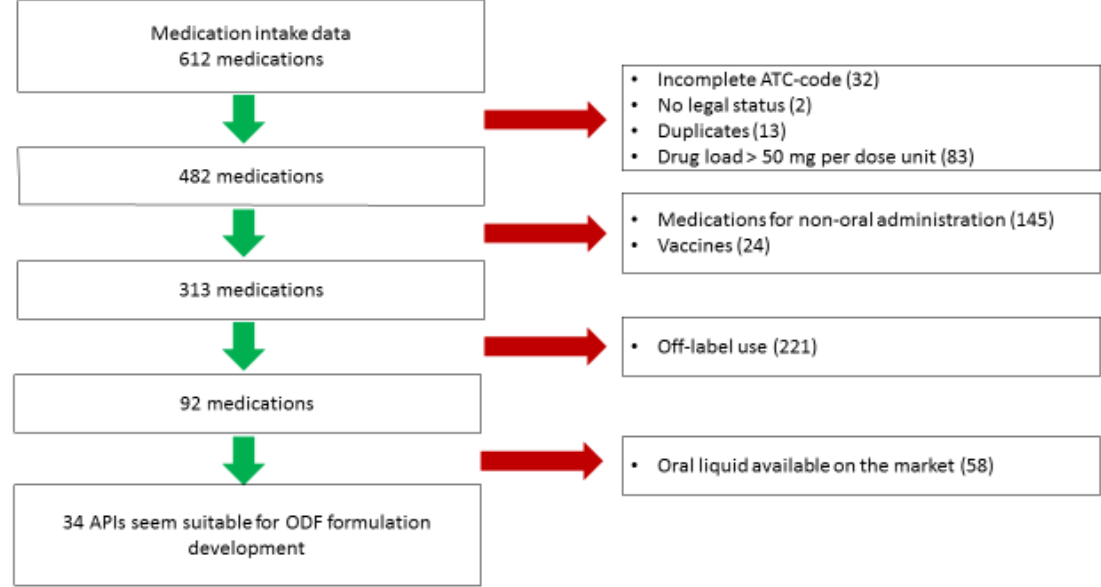
Figure 1. Flowchart for the selection of active pharmaceutical ingredients (APIs) towards orodispersible film (ODF) formulation development.